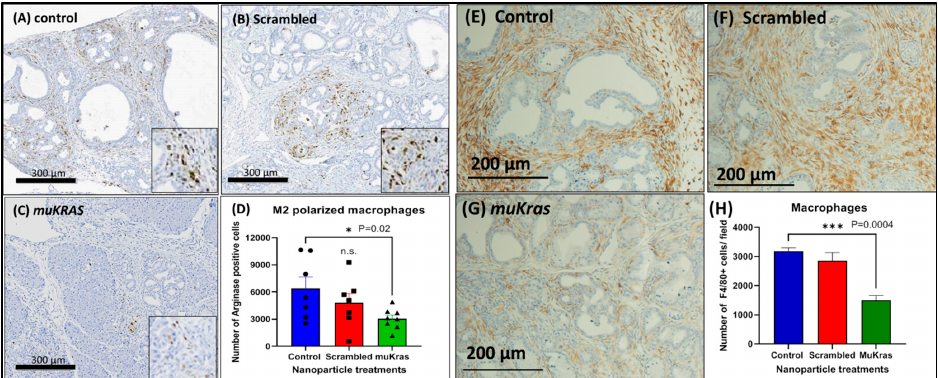
Figure 3. The pancreas microenvironment has fewer immunosuppressive M2-polarized macrophages in mice treated with mu Kras siRNA nanoparticles. ( A ) Arginase positive M2-polarized macrophages are seen in the ECM and are abundant in pancreas of control mice and ( B ) in the pancreas of mice treated with the scrambled siRNA loaded NP. ( C ) A decrease in the arginase staining was observed in the pancreas of the KC mice treated with the mutant Kras loaded NPs. ( D ) The number of arginase positive macrophages was quantified and the number per high powered field were significantly decreased in the pancreas of the KC mice treated with the mutant Kras loaded NP ( p = 0.02). ( E ) F4/80+ macrophages were abundant in the pancreas of control mice and ( F ) in mice treated with the scrambled siRNA. ( G ) Fewer tissue macrophages were identified in the pancreas of mice treated with the mu Kras siRNA NP. ( H ) Quantitative computerized densitometry confirmed fewer macrophages in the pancreas of the mu Kras siRNA NP- treated mice ( p = 0.0004; two-way ANOVA).). *** p < 0.005. Individual data points are represented by circles, squares and triangles in the